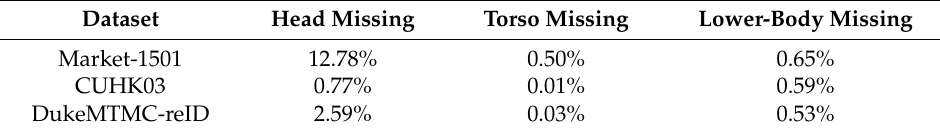
Table 6. Statistics of part missing on Market-1501, CUHK03 and DukeMTMC-reID datasets.